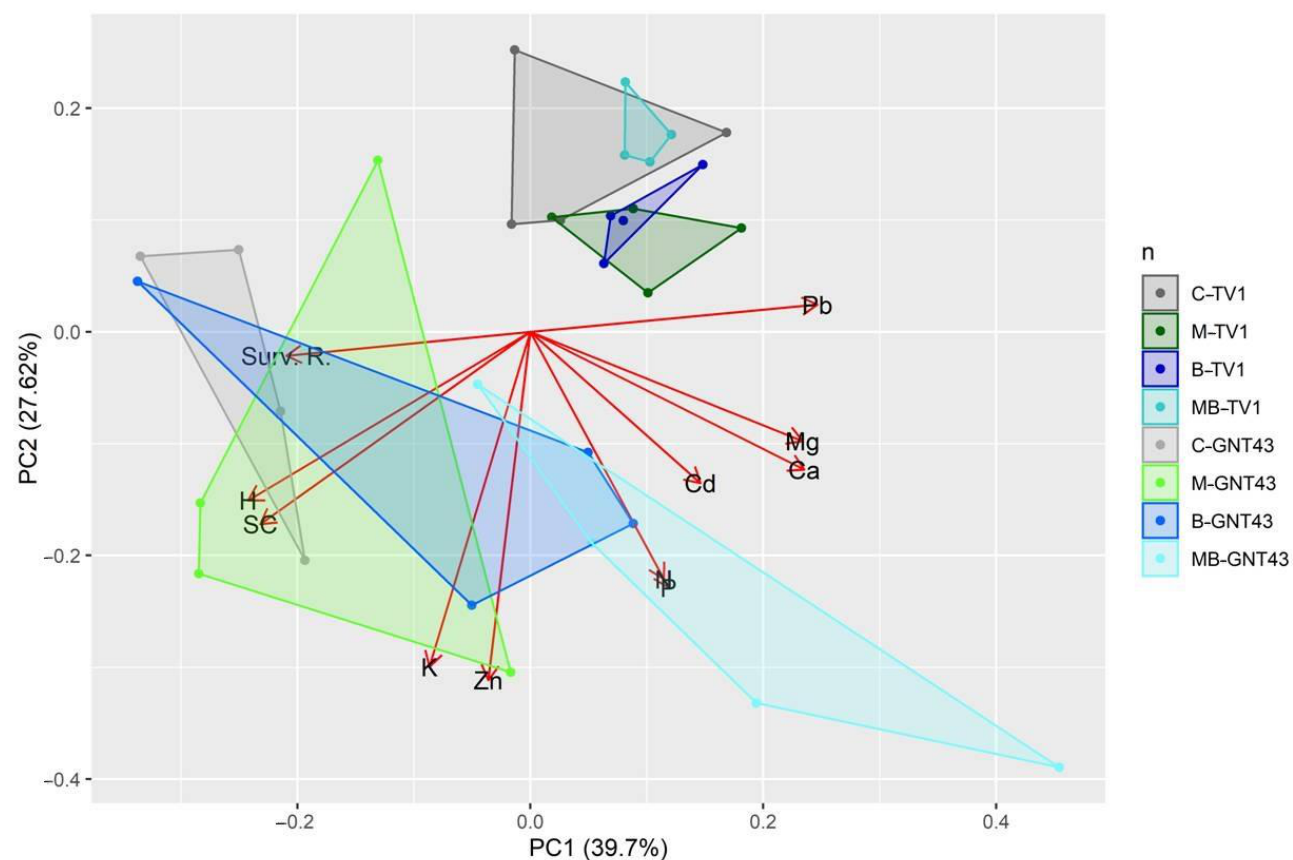
Figure 4. The Principal Component Analysis (PCA) presenting the relationships between selected elements accumulation in shoots and growth parameters of TV1 and GNT43 Miscanthus hybrids cultivated under different agrotechnical treatments: control (C), plastic mulch (M), biochar (B), and plastic mulch + biochar (MB). Growth parameters: H—plant height; SC—stem count; Surv. R.—survival